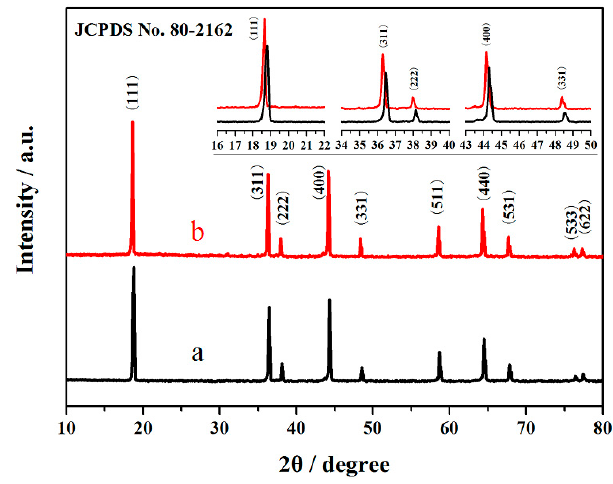
Figure 1. XRD patterns of the LiNi 0.5 Mn 1.5 O 4 ( a ) and Er-doped LiNi 0.5 Mn 1.5 O 4 ( b ).